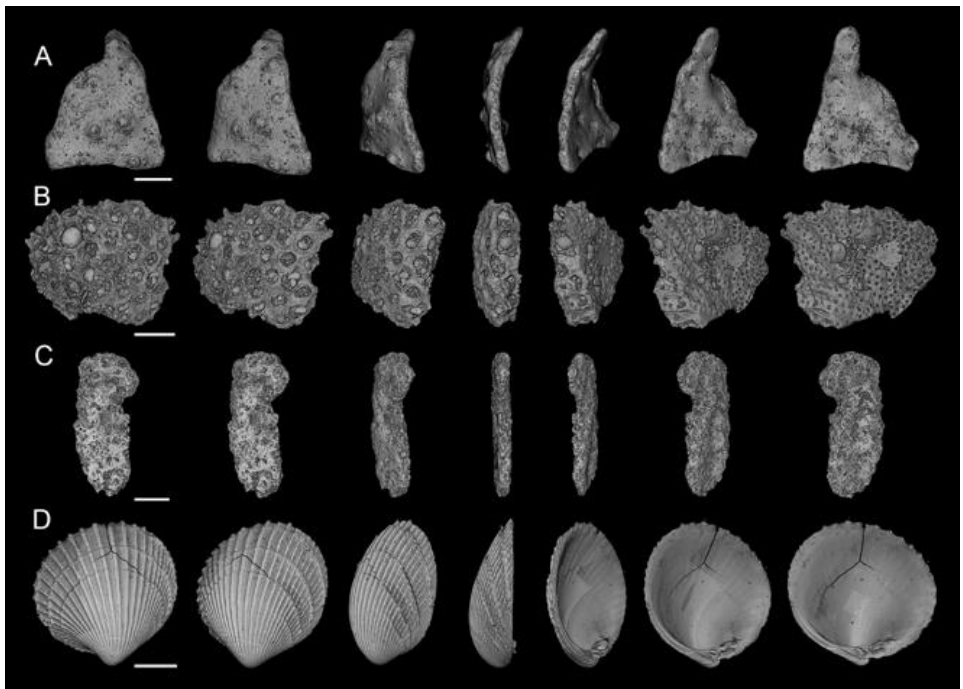
Figure 2. Three-dimensional rendered X-ray µCT images demonstrating typical platy particles from Ledge Point rotated though 180°: ( A ) Bioclast, ( B ) Bryozoan, ( C ) Bioclast, and ( D ) mollusk shell. Table 1. Ledge point sand site and geotechnical index properties (Sharma 2004).